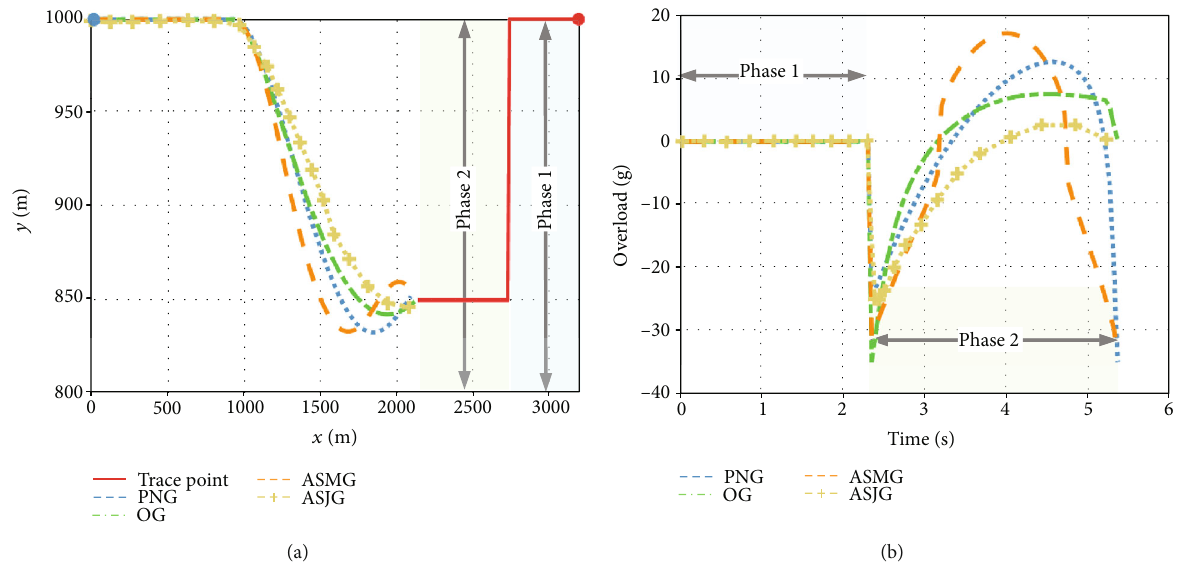
Figure 16: The variation of the state for the single-jump system in the head-on scenario. (a) Trajectories of the missile and trace point; (b) overloads of di ff erent guidance laws.